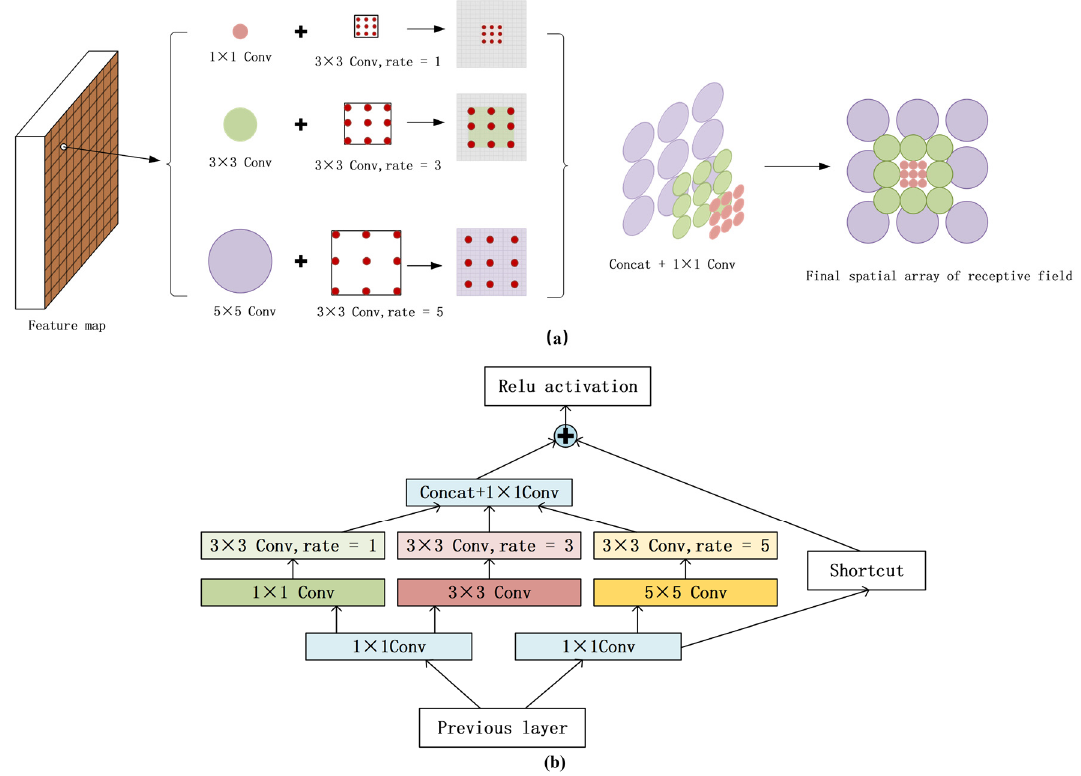
Figure 6. Schematic diagrams of ( a ) the RFB module effect and ( b ) the RFB